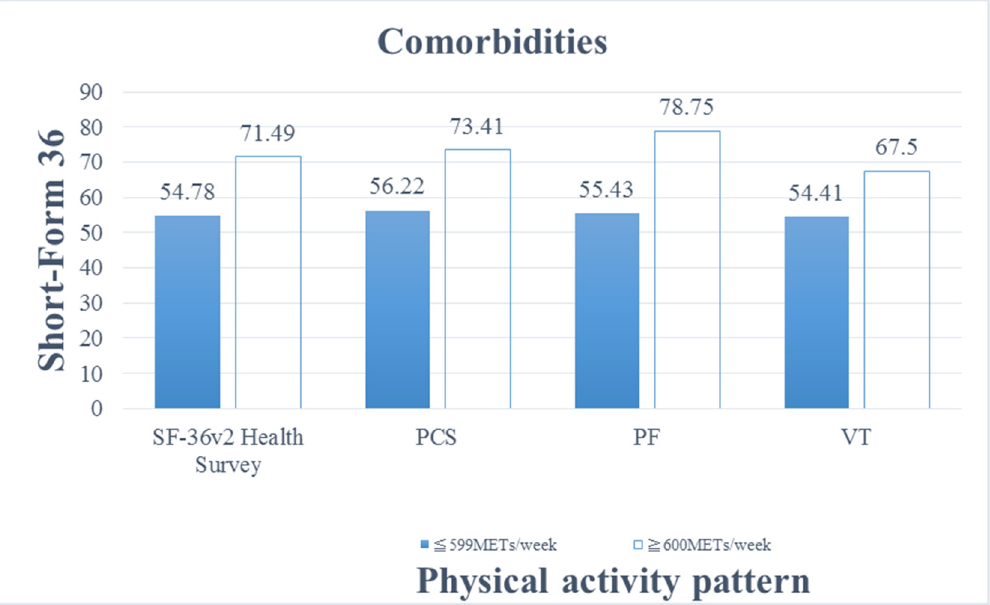
Figure 2. Comparison of physical activity patterns and health-related quality of life of patients on hemodialysis with comorbidities. Abbreviations: Physical Component Summary, PCS; physical functioning, PF; vitality, VT.